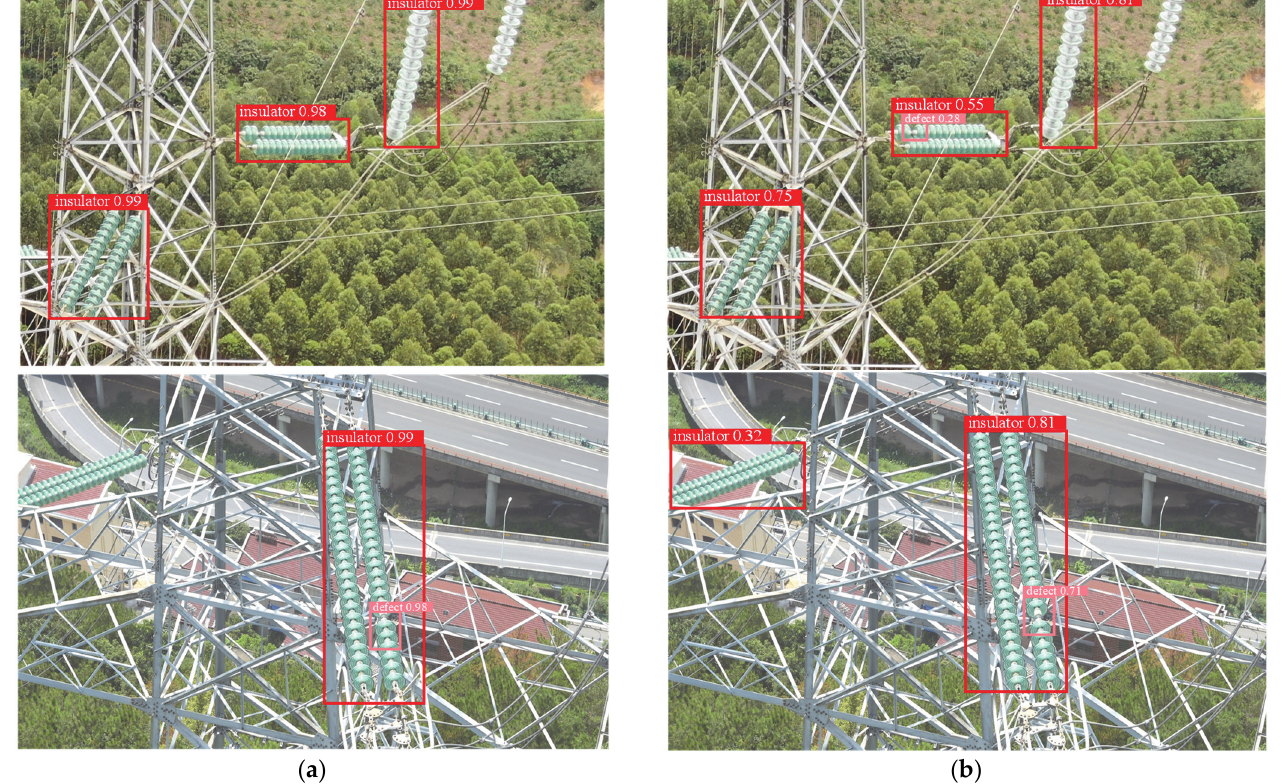
Figure 7. Comparison chart of detection effects. ( a ) Use the cross-entropy loss function model to detect the effect. ( b ) Use the dynamically changing Focal loss function model to detect the effect.